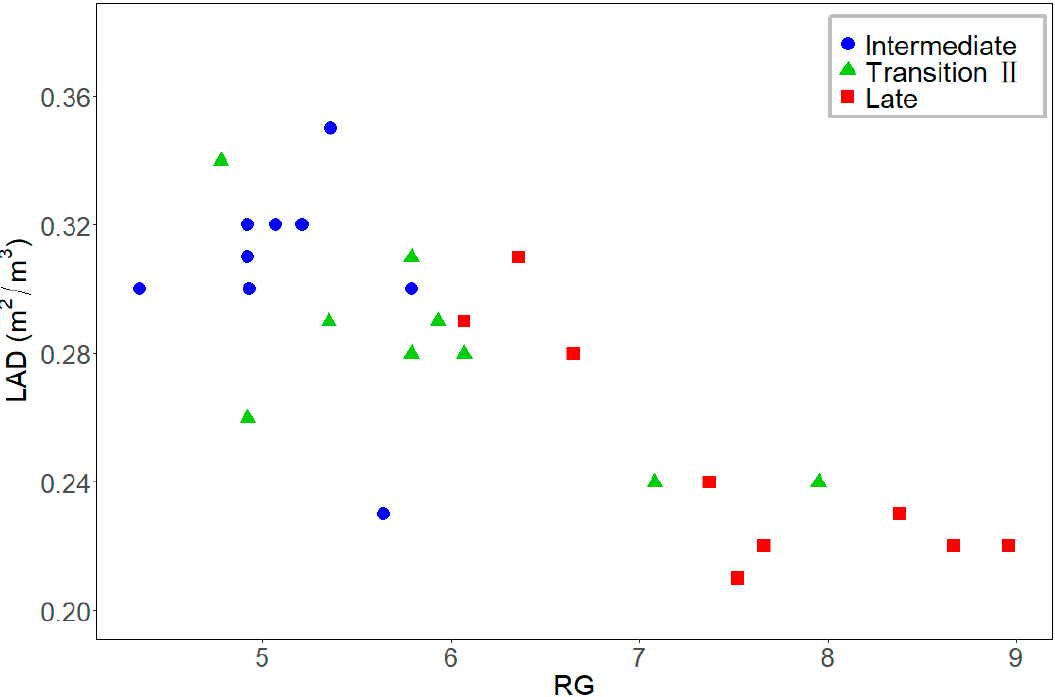
Figure 10. A scatter plot of RG (the radius of gyration) versus LAD (leaf area density) from 27 plots distributed in three successional gradients (Intermediate, Transition II and Late) at the SRNP-EMSS, Guanacaste, Costa Rica.